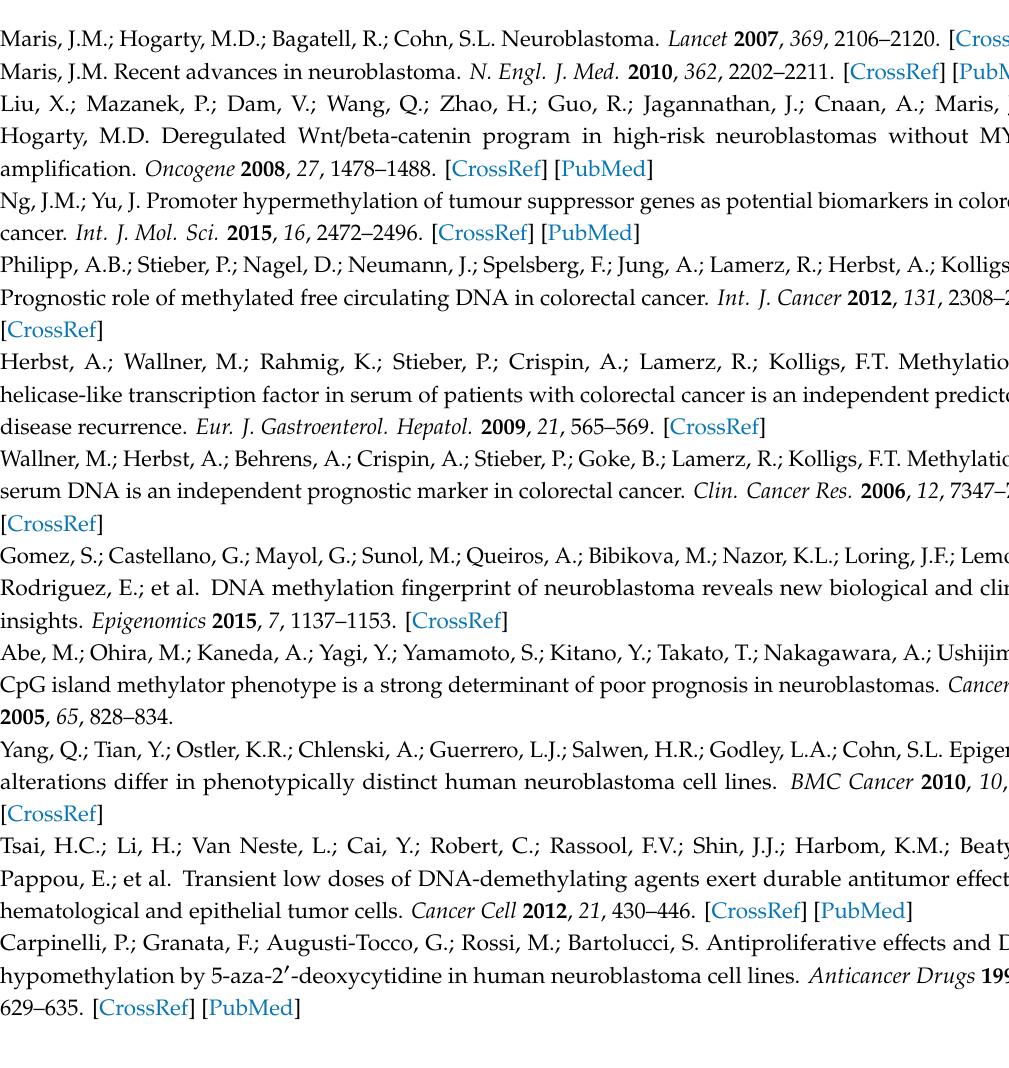
Figure S1. (related to Figure 1B–C); Figure S2. Pyrosequencing design for four sites of the DDX58 / RIG-I promoter; Figure S3; Figure S4. MAVS expression pattern in response to Poly(I:C); Figure S5. Loss of mitochondrial membrane potential and reduction of TOM20 protein level in response to Dac; Figure S6. AS and ρ 0 cells manifest a similar level of DNA damage marker γ H2AX (p-S139), but di ff er in the intracellular dsRNA level; Table S1. Primer sequences used for